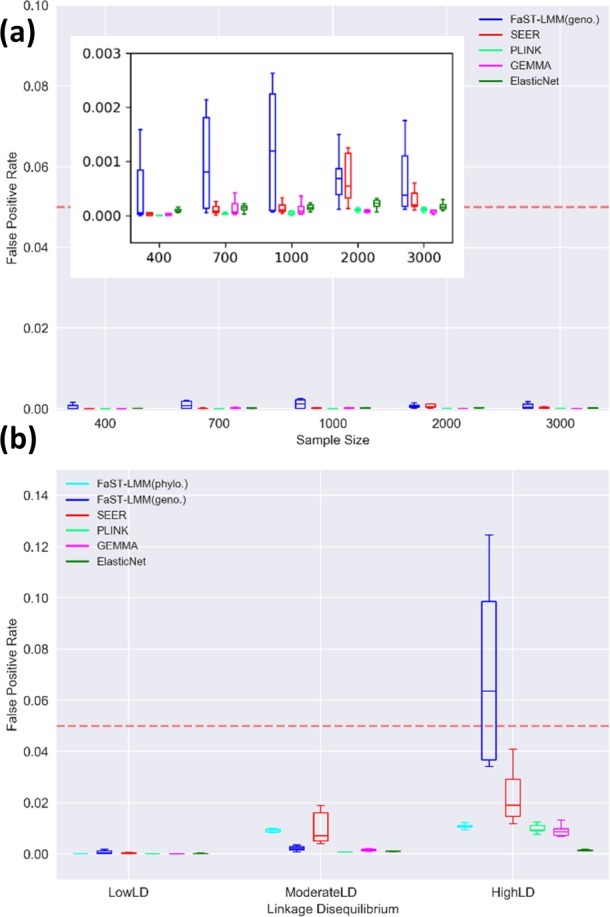
 FPRs are generally acceptable across methods. FPRs are shown (a) across a range of sample sizes at low LD, and (b) across a range of LD in a sample size of 3000 genomes. The typical threshold of FPR=0.05 is displayed as a dotted red line. Note that the FPR is already corrected for multiple tests, since it is calculated based on the number of false positives and true negatives identified after Bonferroni correction (see Methods). The inset in panel (a) shows the same data as in the main image with an adjusted y-axis for better clarity. Boxplots show the median and interquartile range, averaged across a range of effect sizes over ten replicates in each scenario (log OR=1 to 3).